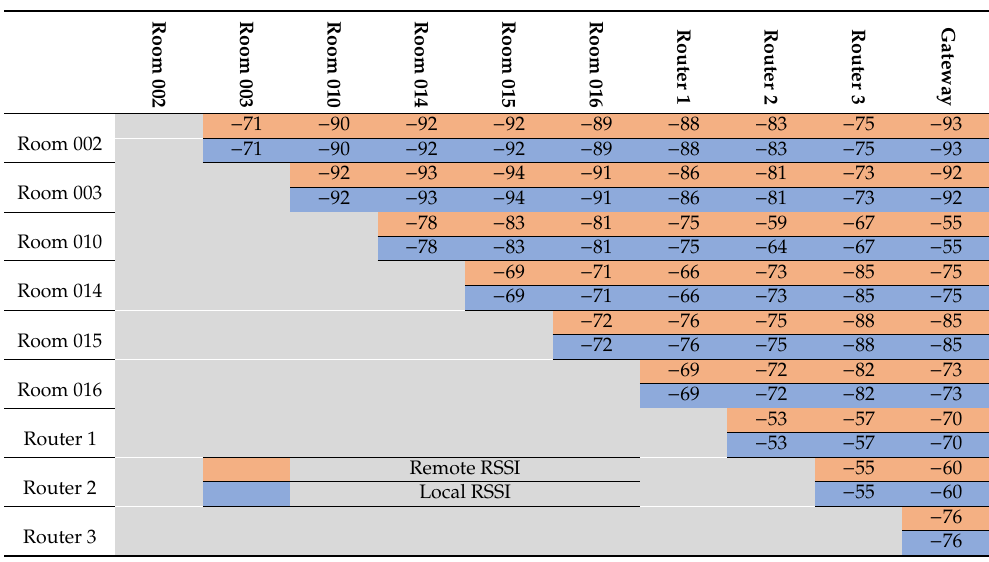
Figure 8. Local and remote Remote Signal Strength Indicator (RSSI) of WSN nodes. Table 6. RSSI measurements between each pair of WSN nodes.